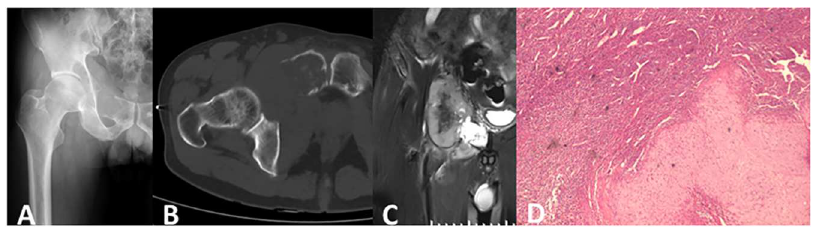
Fig 4. Dedifferentiated chondrosarcoma of the right pelvis in a 58-year-oldman (Case 15). (A). Anteroposterior radiograph demonstrated osteolytic bone destructionand a soft tissue mass without chondral or osteoidmatrix mineralization. (B). CT showedpunctate chondralmatrix mineralization in the intraosseous medullary cavity, whichmight be high-grade chondrosarcoma. (C). Fat-suppressed coronalT2-weightedimage showeda clear demarcation betweenpredominantreducedsignalintensity(dedifferentiated component) and chondralsignalintensity.(D). Pathological section(HE X40) showedfeatureof the low gradechondrosarcoma andhigh grademalignant fibroushistiocytoma.